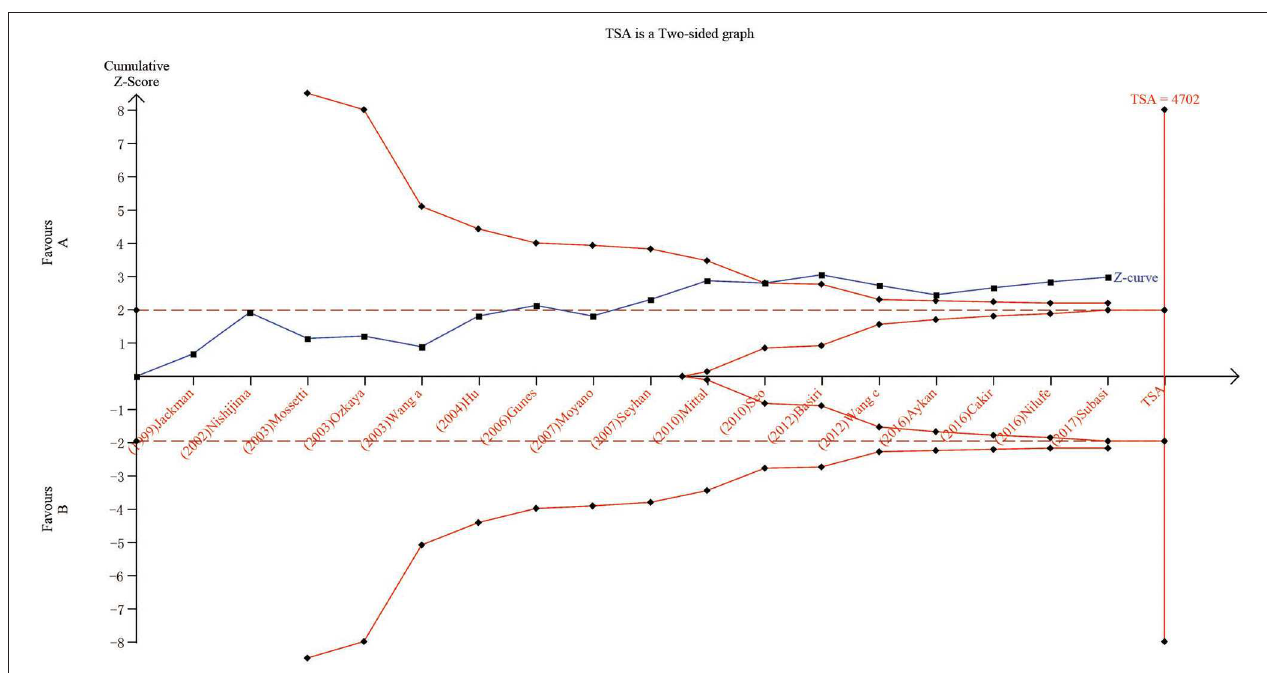
FIGURE 5 | Results of TSA with TaqI variant. The required information size was calculated based on a two-sided α = 5%, β = 15% (power 80%), and a relative risk reduction of 20%.